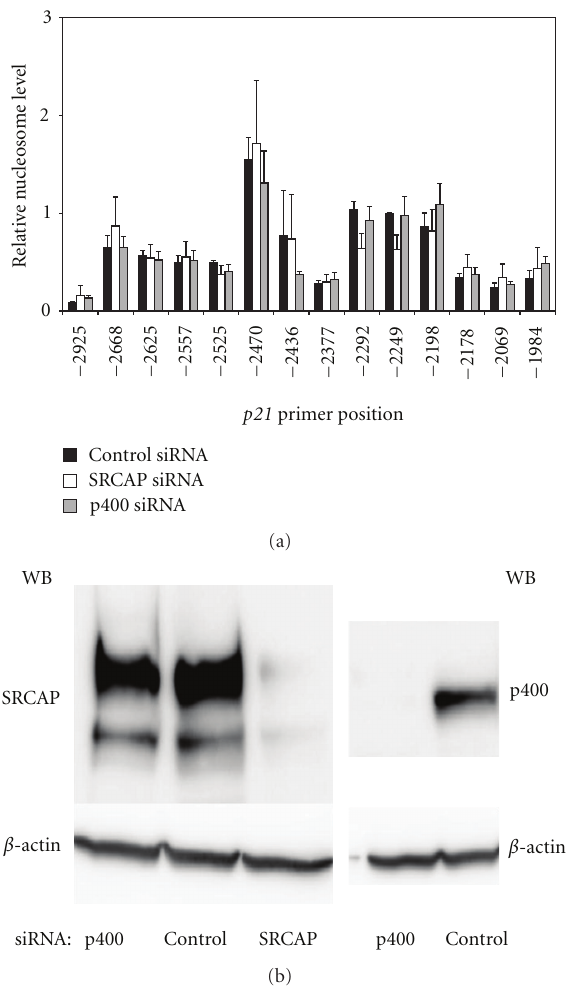
Figure 1: The density of nucleosomes at the p21 promoter nucle- osome is not altered in the absence of SRCAP or p400. A549 cells were transfected with control, SRCAP or p400 siRNA and harvested 72 hours later. In (a), DNA was isolated from mononucleosomes and amplified by qPCR using overlapping primers tiling the p21 promoter (see Table S1(c)) and presented relative to the amount of DNA amplified at position − 2249. The graph represents the mean result and standard error of three or more independent ChIP experiments. In (b), knockdown of SRCAP or p400 protein, compared to control-transfected cells, was confirmed by Western blot. Beta actin was used as a loading control.